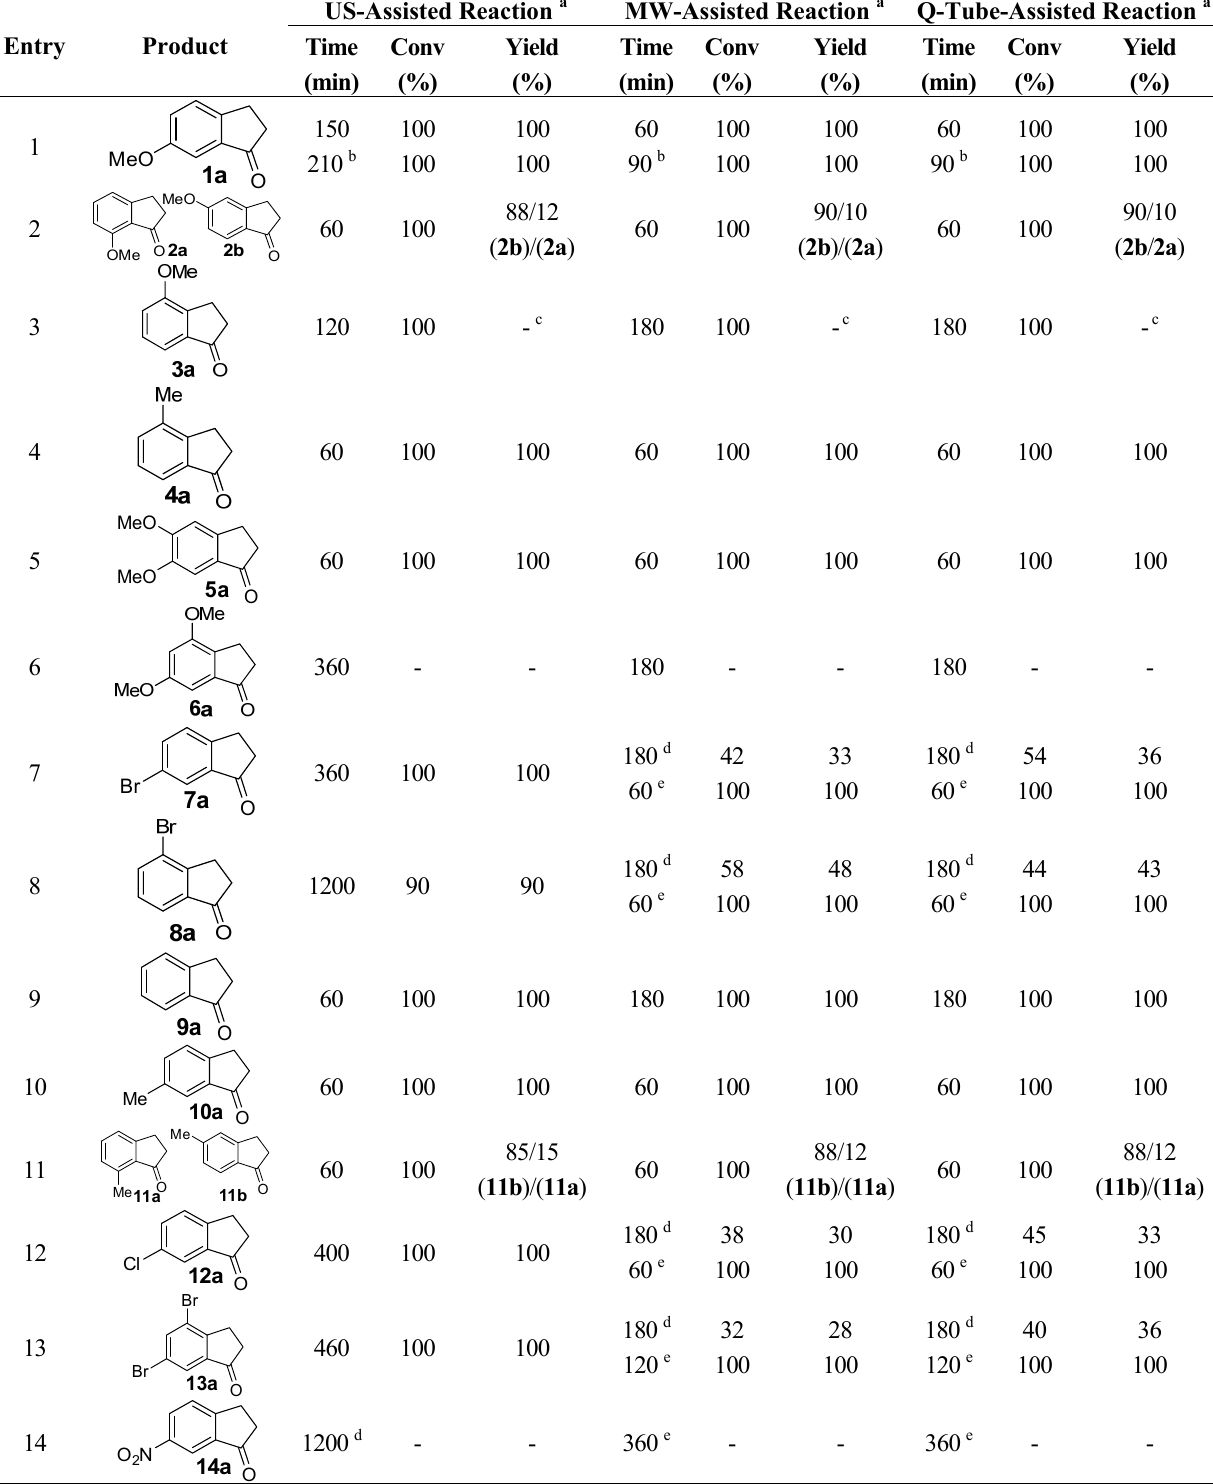
Table 3. MW vs. US method in the intramolecular Friedel-Craft acylation of phenyl propionic acids 1 – 7